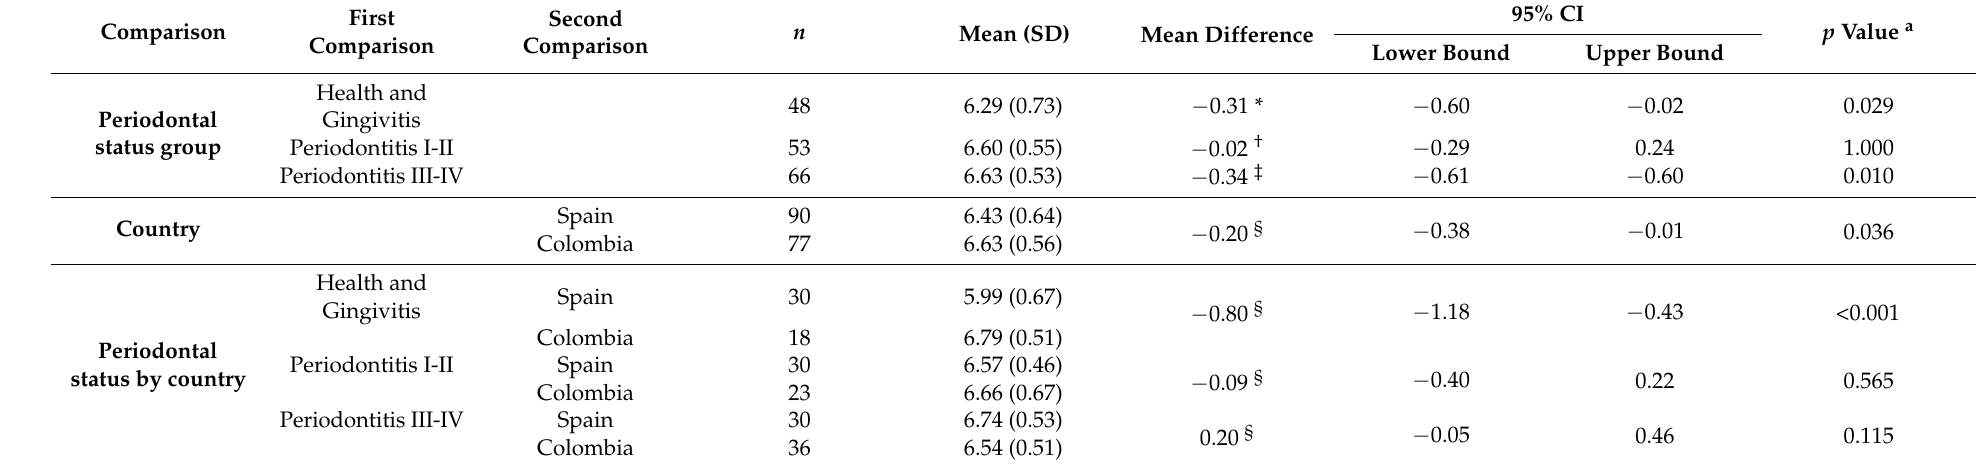
Table 4. Comparison of total anaerobic counts (log transformed) among periodontal status groups (first comparison) and between countries (second comparison). Comparison